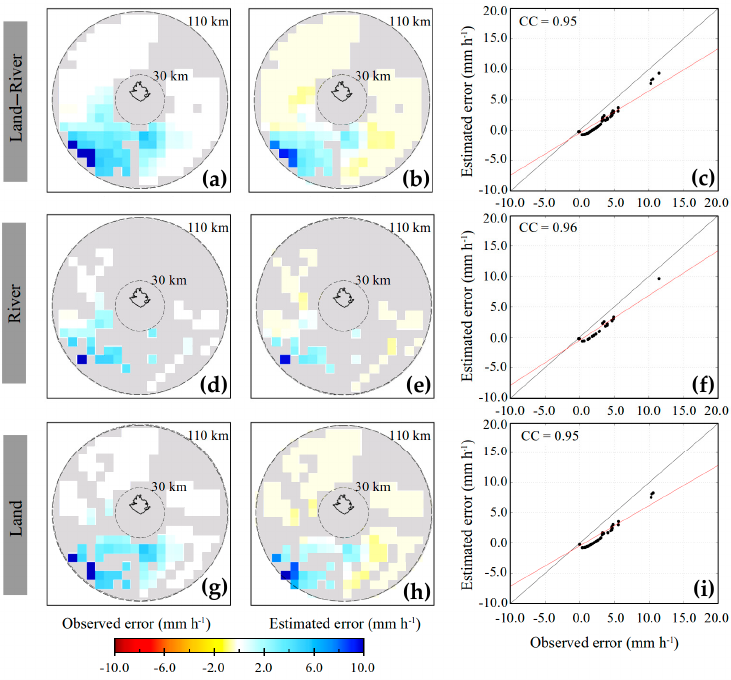
Figure 5. Comparisons of observed and estimated errors during a single time step (06:30–06:59 UTC on 28 May 2015) over land–river ( a – c ), river only ( d – f ), and land only ( g – i ), during the dry validation period. The observed error is defined as the difference between the Integrated Multisatellite Retrievals for Global Precipitation Measurement (IMERG) satellite retrieval and the S-band SIPAM radar observation. The estimated error is defined as difference between the satellite and the estimated reference precipitation (not shown). The scatterplots ( c , f , i ) show estimated error versus observed error.